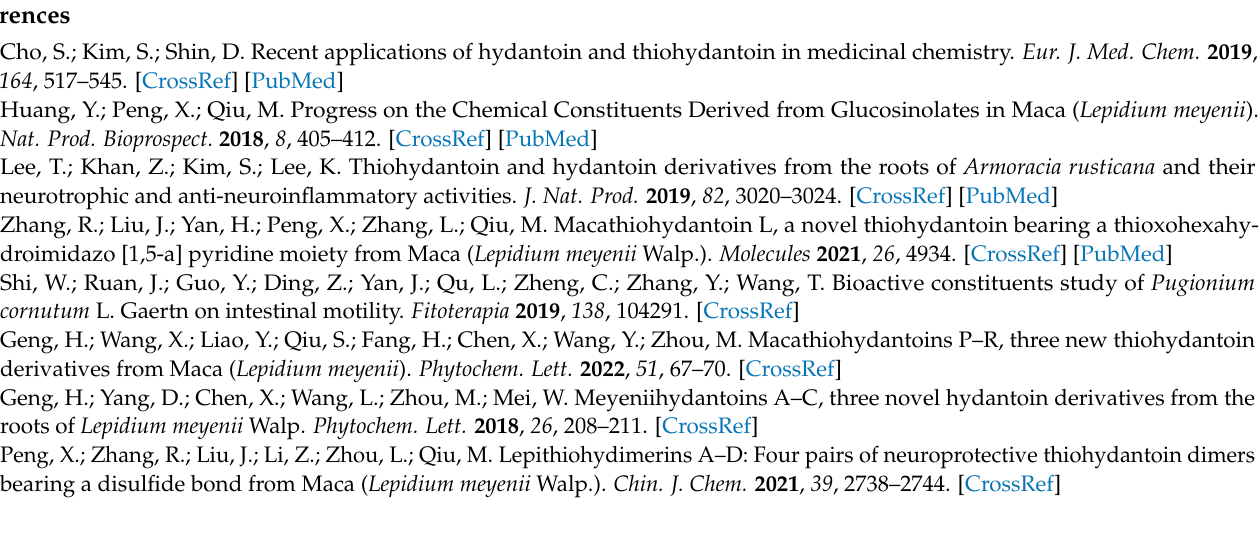
versus experimental 13 C NMR chemical shifts. (Left (5R, 7R, 8S)- 1 , Right (5S, 7R, 8S)- 1 ). Figures S2–S8: NMR, IR, UV, and MS spectra; Table S1: Geometry data of conformers of isomer 1a and isomer 1b ; Figure S2: (+)-HRESIMS spectrum of compound 1 ; Figure S3: (+)-HRESIMS spectrum of compound 1 ; Figure S4: The UV spectrum of compound 1 in MeOH; Figure S5: The IR spectrum of compound 1 ; Figure S6: The 1 H NMR spectrum of compound 1 in MeOH-d4 (500 MHz); Figure S7: The 13 C NMR spectrum of compound 1 in MeOH-d4 (125 MHz); Figure S8: The 1 H- 1 H COSY spectrum of compound 1 in MeOH-d4 (500 MHz); Figure S9: The HSQC spectrum of compound 1 in MeOH-d4 (500 MHz for 1 H); Figure S10: The HMBC spectrum of compound 1 in MeOH-d4 (500 MHz for 1 H); Figure S11: The ROESY spectrum and enlarged ROESY spectrum of compound 1 in MeOH-d4 (500 MHz); Figure S12: The 1 H NMR spectrum of compound 1 in DMSO-d6 (600 MHz); Figure S13: The 13 C NMR spectrum of compound 1 in DMSO-d6 (150 MHz); Figure S14: The DEPT spectrum of compound 1 in DMSO-d6 (150 MHz); Figure S15: The 1 H- 1 H COSY spectrum of compound 1 in DMSO-d6 (600 MHz); Figure S16: The HSQC spectrum of compound 1 in DMSO-d6 (600 MHz for 1 H); Figure S17: The HMBC spectrum of compound 1 in DMSO-d6 (600 MHz for 1 H); Figure S18: The NOESY spectrum and enlarged NOESY spectrum of compound 1 in DMSO-d6 (600 MHz); Figure S19: (+)-HRESIMS spectrum of compound 2 (page 1); Figure S20: (+)-HRESIMS spectrum of compound 2 (page 2); Figure S21: The UV spectrum of compound 2 in MeOH; Figure S22: The IR spectrum of compound 2 ; Figure S23: The 1 H NMR spectrum of compound 2 in MeOH-d4 (500 MHz); Figure S24: The 13 C NMR spectrum of compound 2 in MeOH-d4 (125 MHz); Figure S25: The DEPT spectrum of compound 2 in MeOH-d4 (125 MHz); Figure S26: The 1 H- 1 H COSY spectrum of compound 2 in MeOH-d4 (500 MHz); Figure S27: The HSQC spectrum of compound 2 in MeOH-d4 (500 MHz for 1 H); Figure S28: The HMBC spectrum of compound 2 in MeOH-d4 (500 MHz for 1 H); Table S1: Geometry data of conformers of isomer 1a and isomer 1b